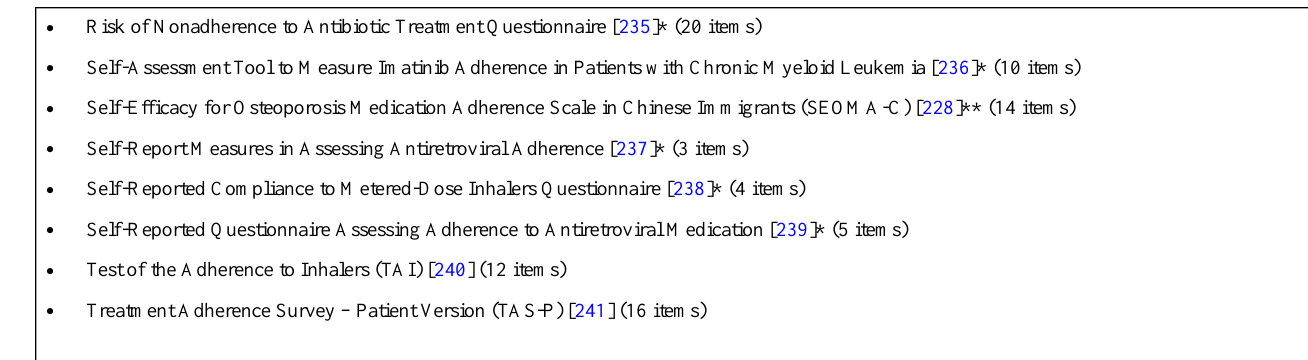
Table 2. Summary of domains and the number of items in each bin.